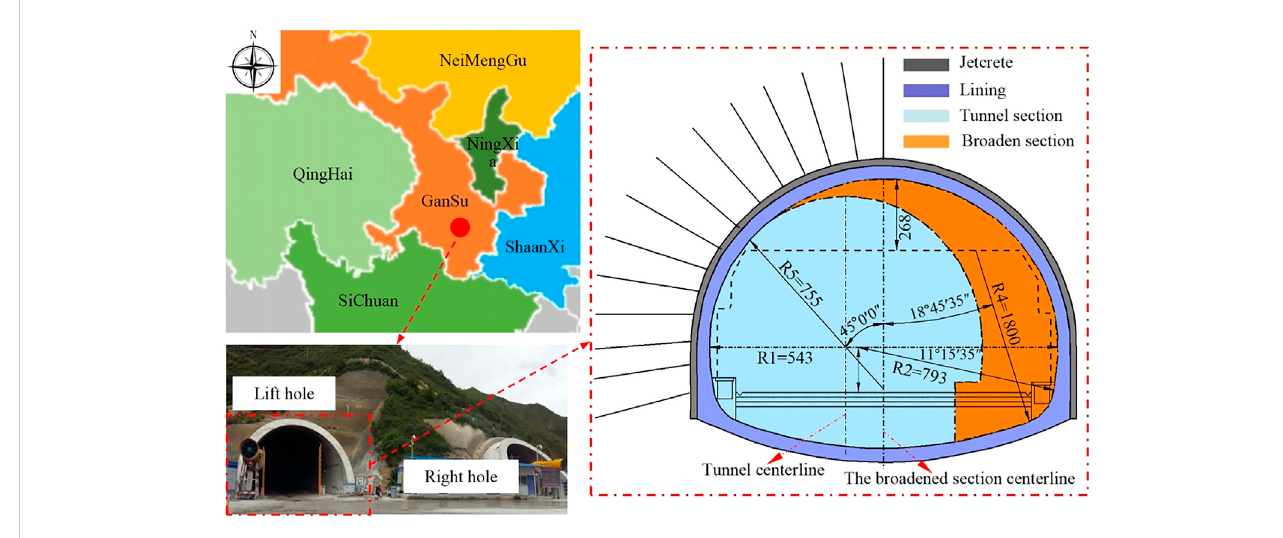
FIGURE 1 Basic information of Gelong Tunnel.